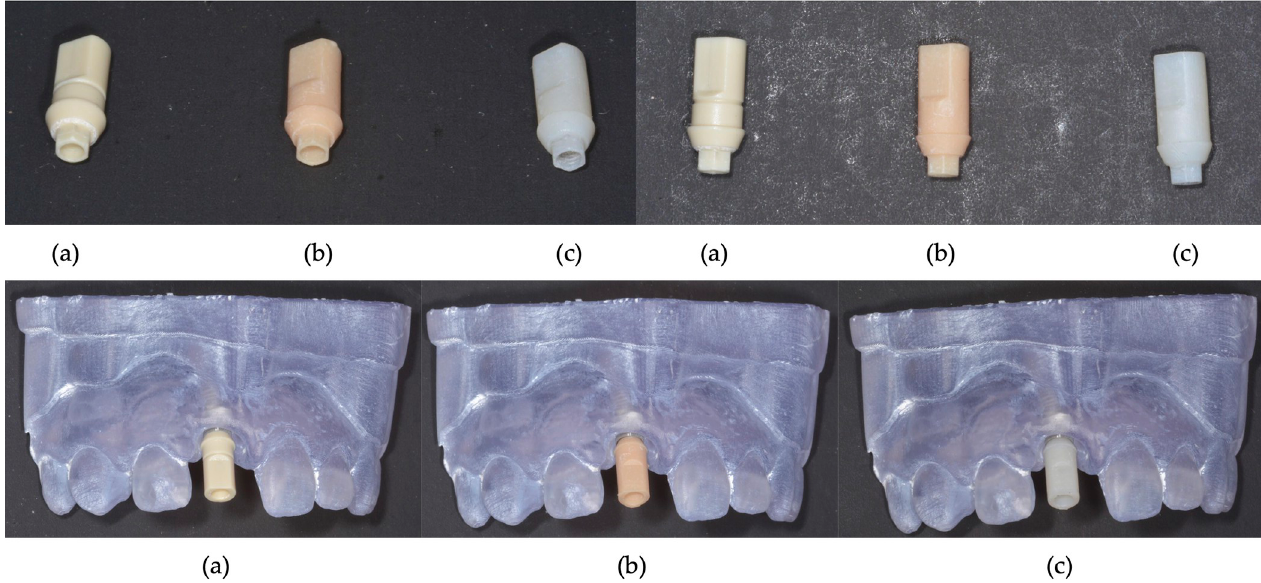
For the SprintRay scan bodies, the same STL file which produced the final batch of For- mlabs scan bodies was imported into their proprietary 3D CAD software (RayWare, Sprin- tRay), where printing supports and rafts were added to the scan bodies. One batch of 10 scan